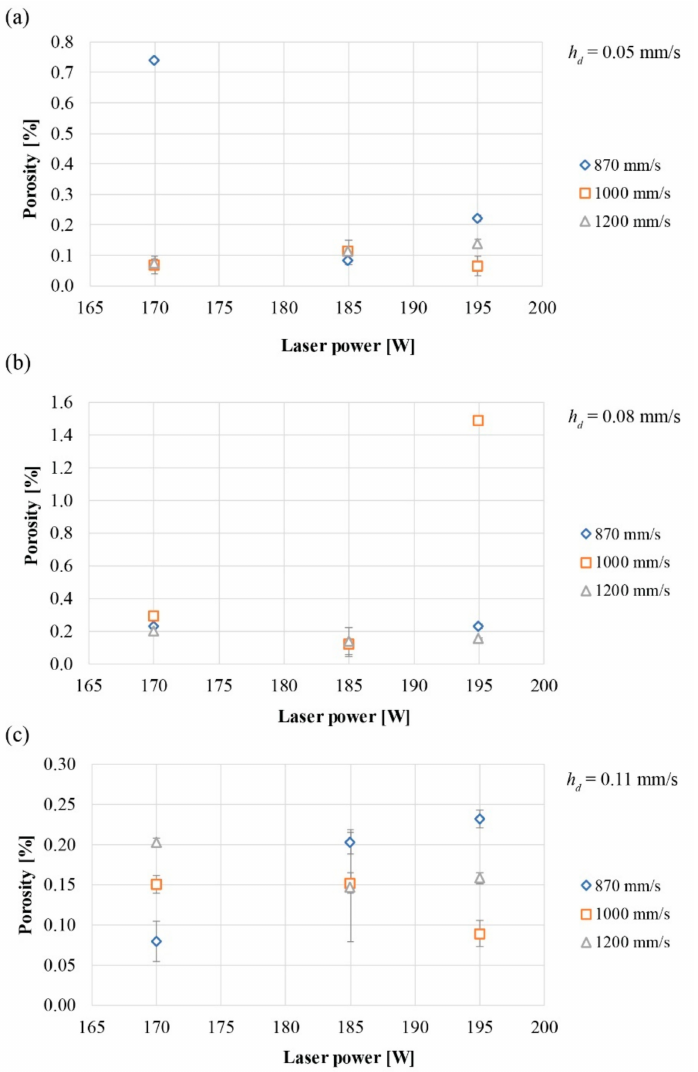
Figure 4. Porosity obtained for di ff erent values of scan speed and laser power with respect to hatching distance of ( a ) 0.05 mm / s, ( b ) 0.08 mm / s, and ( c ) 0.11 mm /